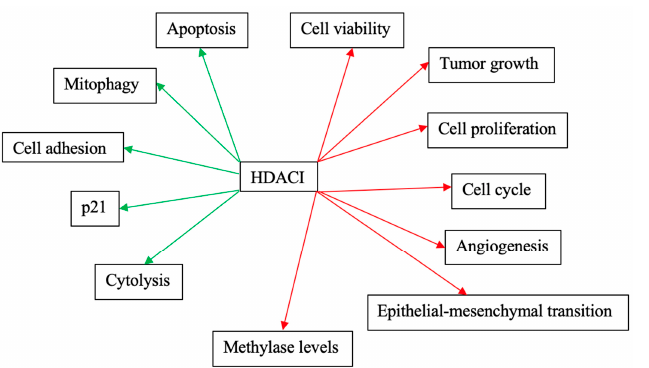
Figure 3. Mechanisms of action of the most studied HDACIs as monotherapies on cervical cancer. Red arrows: Inhibitory effects. Green Arrows: Activating effects. Table 3. Major effects of phytopharmaceuticals as monotherapies on cervical cancer. Phytopharmaceutical